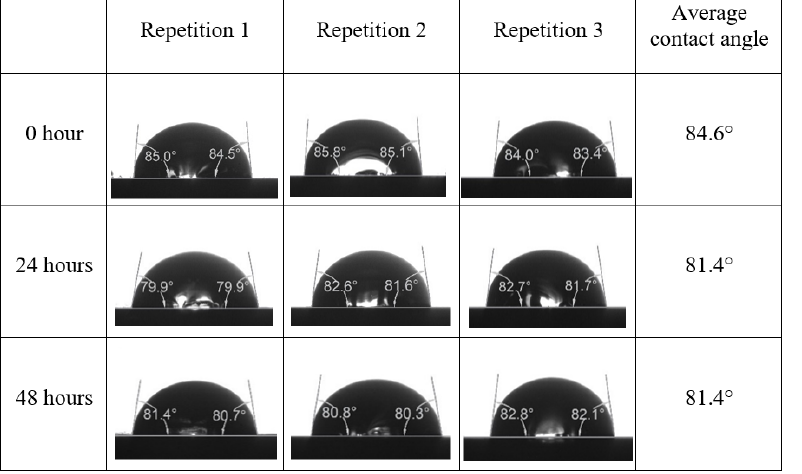
Figure A10. Dynamic Contact Angle Measurement Results for 50% MgCl 2 + 50% NaCl (3500 ppm).